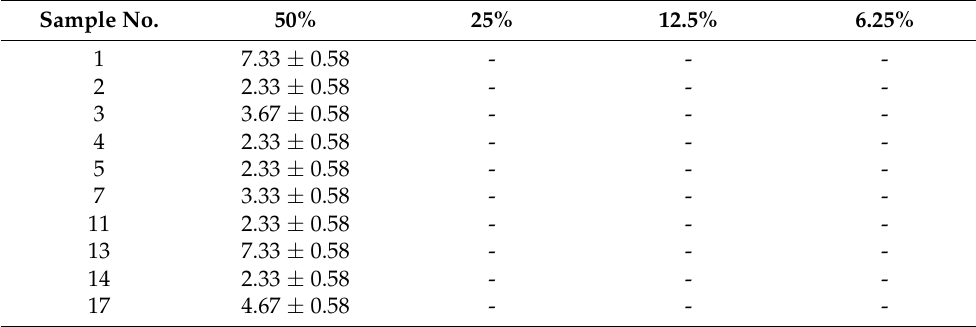
Table 8. Antimicrobial activity of samples against C. glabrata in mm. Sample